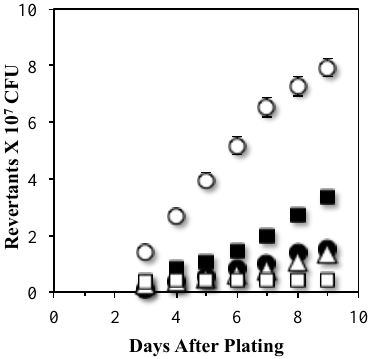
Figure 4. MutY- and NER-dependent SPM pathways operate through Mfd. Frequencies of stationary- phase reversions for leu mutant allele of the B. subtilis strains YB955 (parental strain) ( ○ ), PERM687 ( uvrA ) ( ■ ), PERM704 ( mutY ) (●), PERM1352 ( uvrA mutY ) (Δ) and PERM1353 ( uvrA, mutY mfd ) (□) were obtained as described in Materials and Methods. Data represent the average of three separate tests ± standard error of the mean (SEM).